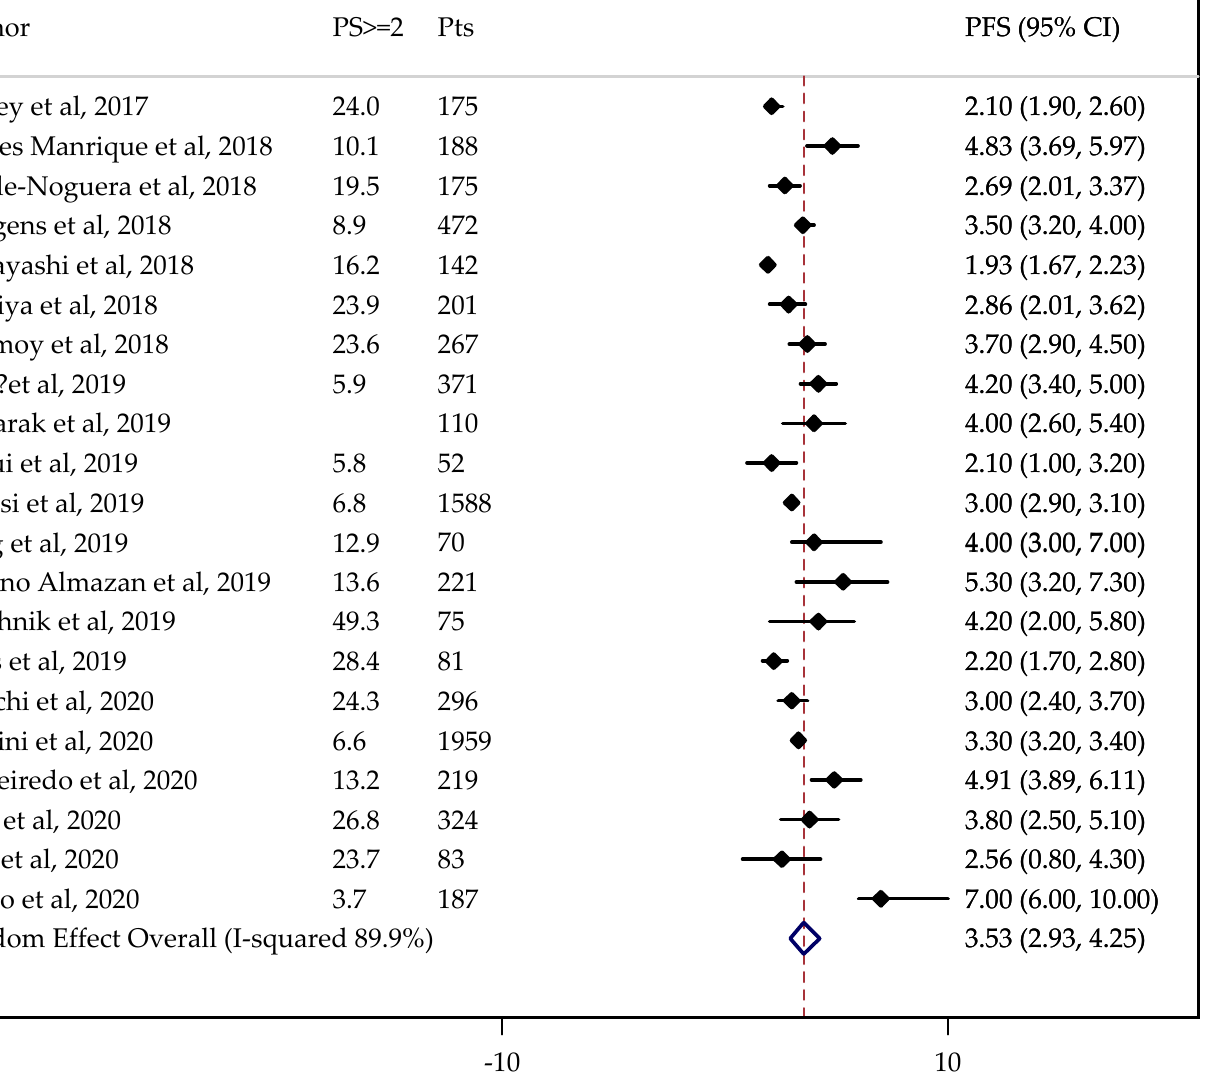
Figure 4. Forest plot of NSCLC progression-free survival (PFS) adjusted for performance status (PS). PS ≥ 2: proportion of patients with PS ≥ 2.